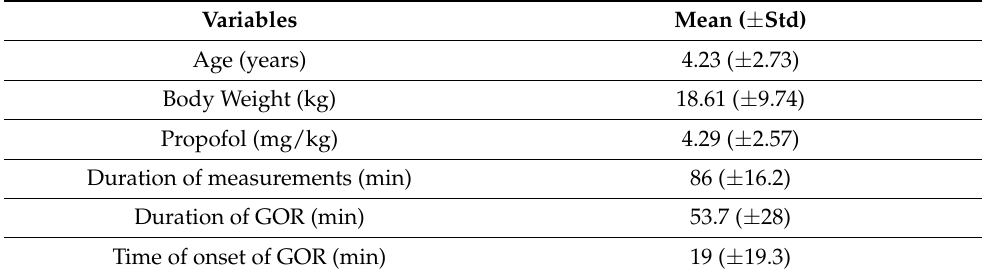
Std: standard deviation, N: total number of dogs included in the